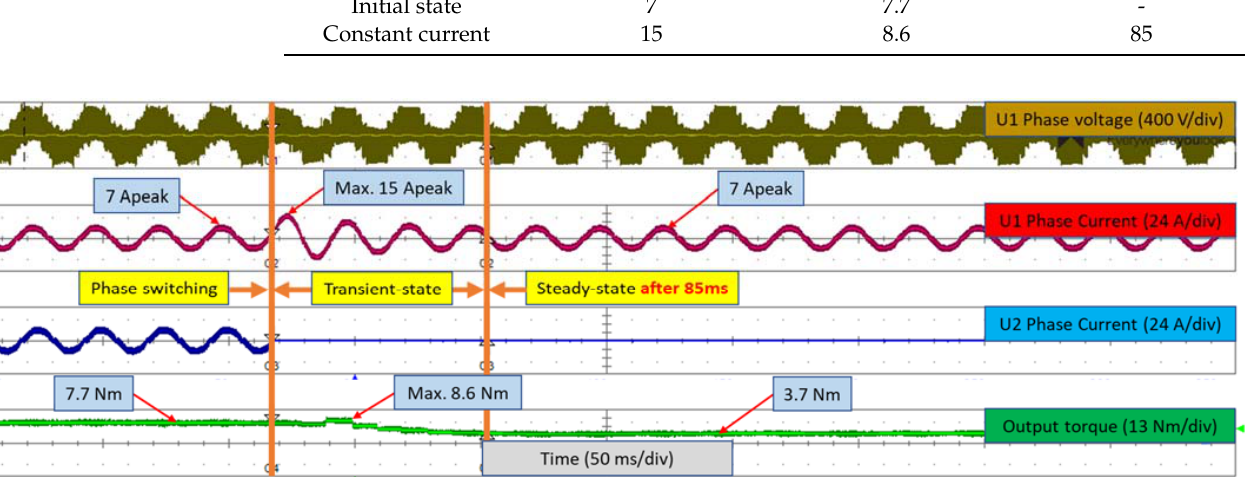
Figure 17. Transient state of constant-current mode at 480 r/min and 5 A. Table 11. Transient state of constant-current mode.